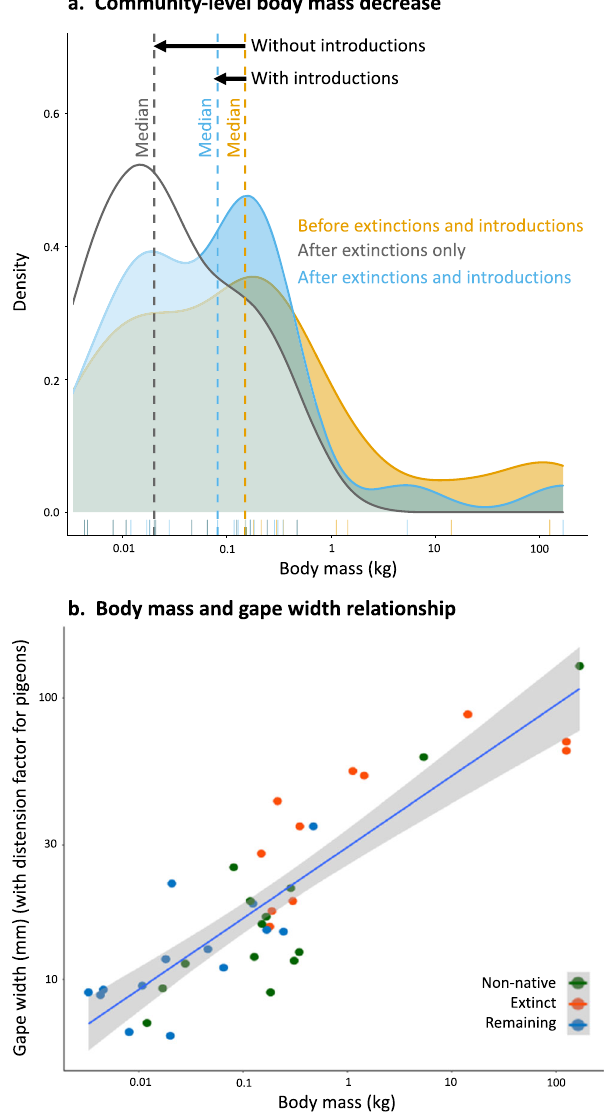
Fig.1|Community-levelbodymassdecreaseonMauritiusandtherelationship between body mass and gape with. a Community-level changes in body mass of frugivores in Mauritius, before and after extinctions and introductions of birds, mammalsandreptiles.Thedecreaseinmedianbodymasscausedbytheextinction of many large frugivores (community median before 159g to 20g after, without introducedfrugivores)appearstobepartiallycompensatedforbytheintroduction of non-native frugivores (community median before 159g to 85g after, with introduced frugivores). b Frugivores on Mauritius with larger body mass have lar- ger gape sizes (as width of bill or mouth) than smaller species, possibly enabling them to swallow and disperse larger seeds (linear regression in R, all frugivores, n =40 species, p =2 − 16 , adj. R 2 =0.76, df=38, standard error in gray, pigeon gapes distended 1.9 times according to Meehan et al. 26